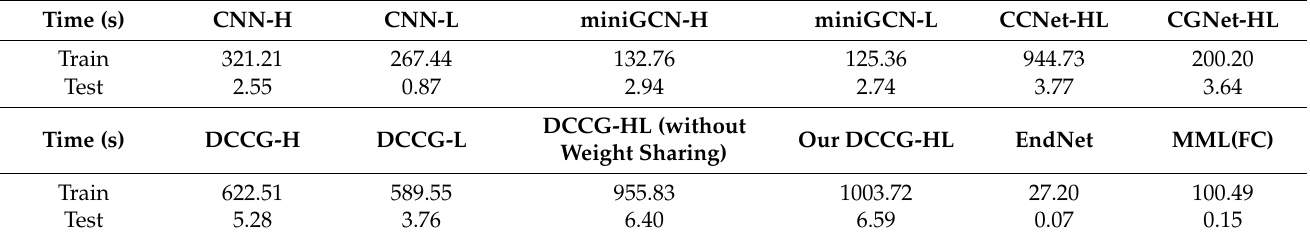
Table 9. Computation time (seconds) of different methods on the Houston